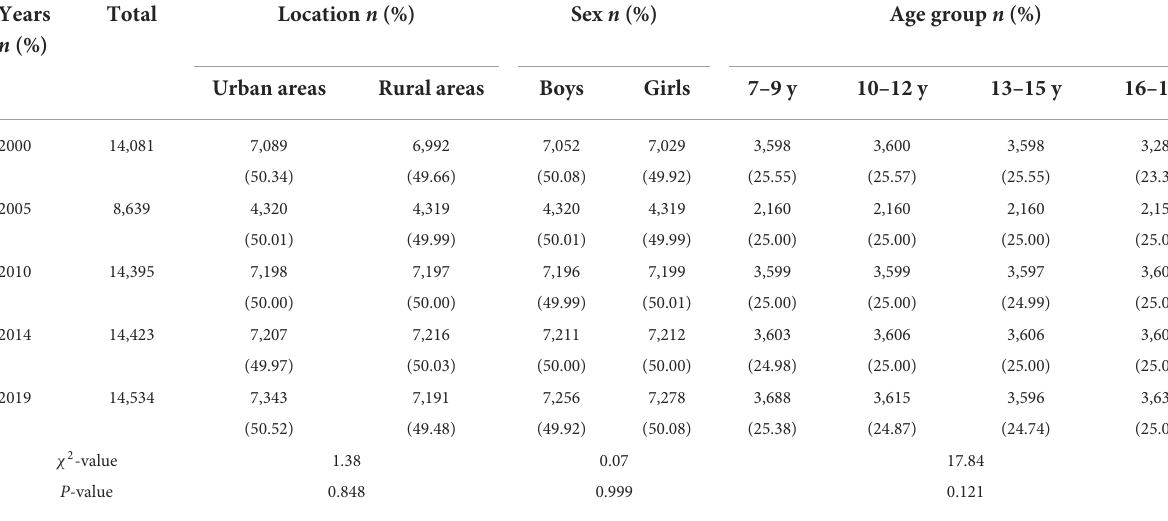
TABLE 1 The sample size for different survey years of the CNSSCH in Henan province,